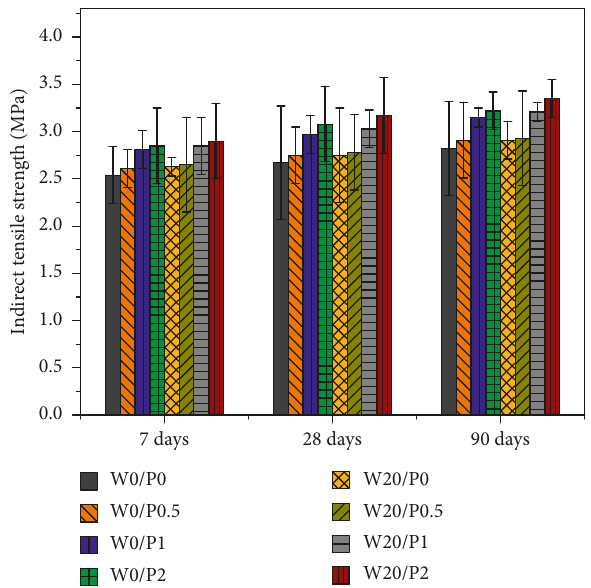
Figure 8: Ultrasonic pulse velocity of the mortar specimens. Figure 7: Indirect tensile strength of the mortar